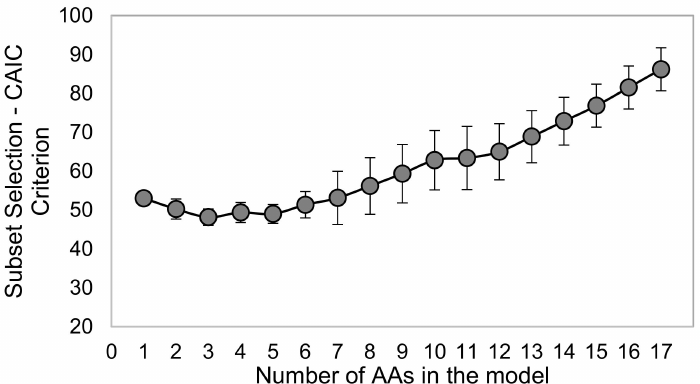
Figure 4. The results of best variable selection procedure. The average and standard deviation of CAIC criterion of the 1- to 17-AA best subset models over all 25 iterations of five repeated five-fold CV are